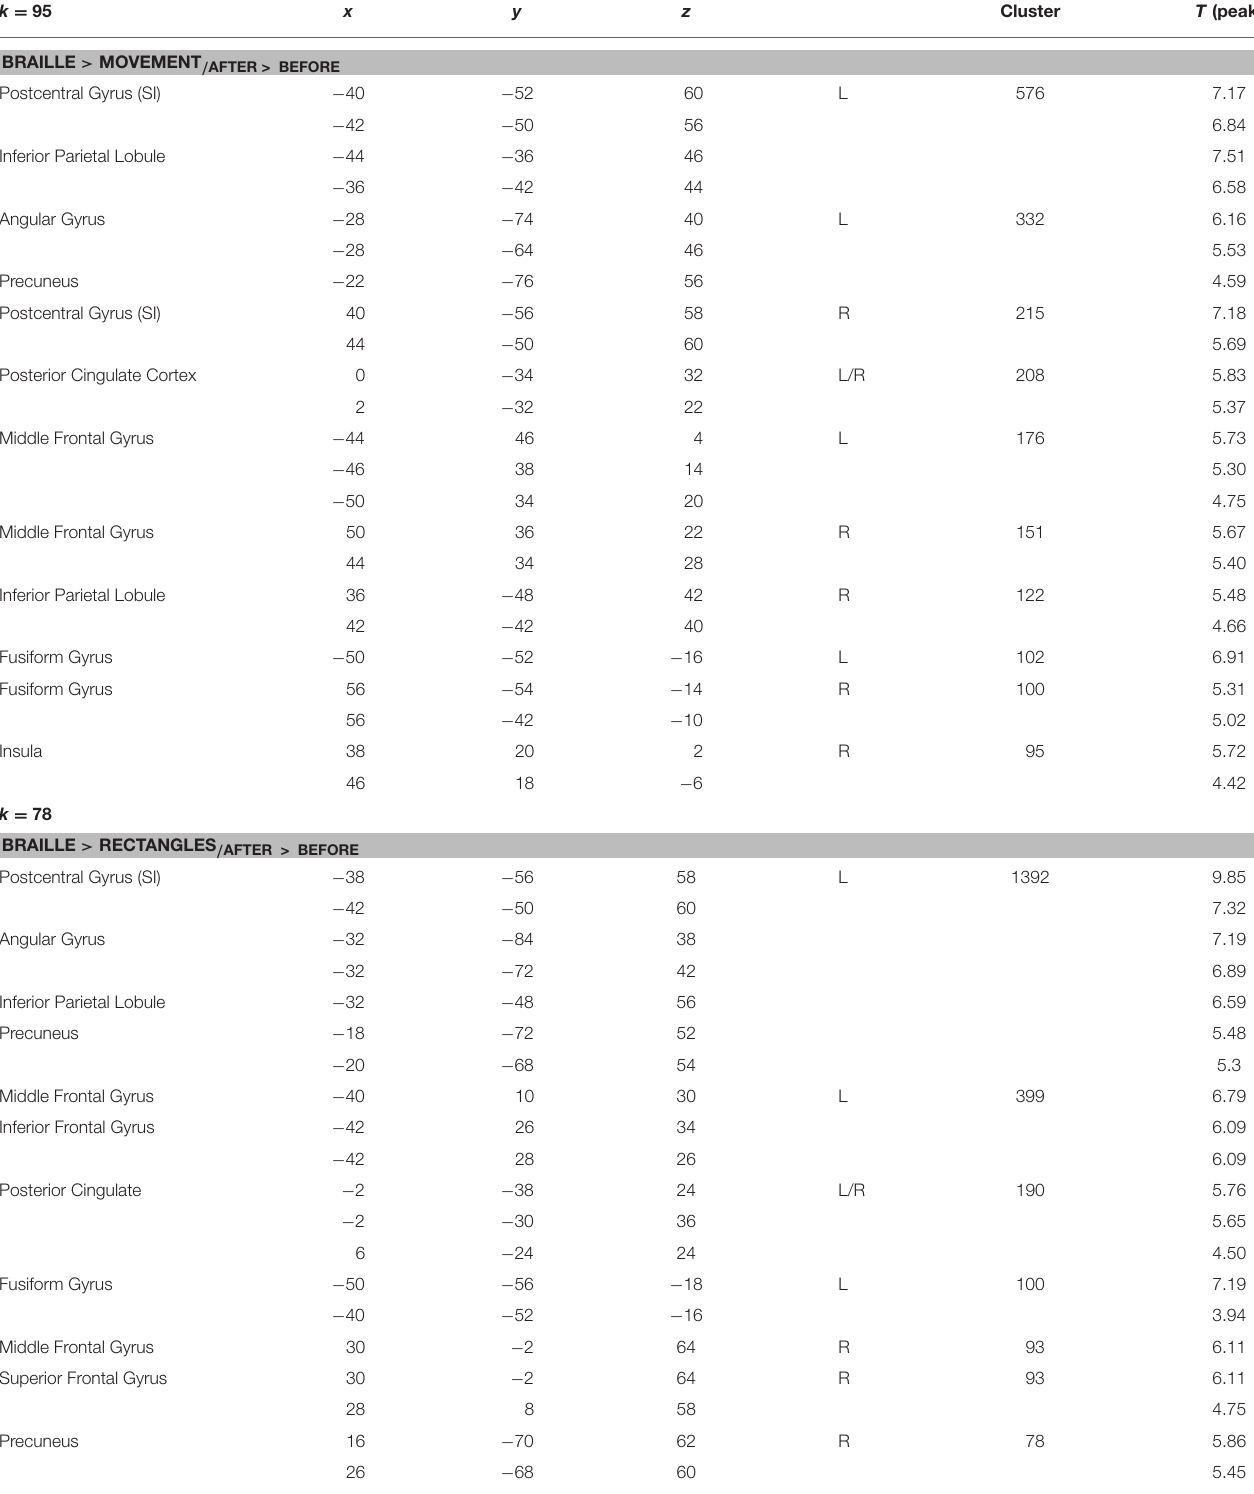
TABLE 1 | Regions showing significant increases in activation as a result of the Braille training (Braille discrimination vs. control tasks × session interaction). k = 95 x y z Cluster T